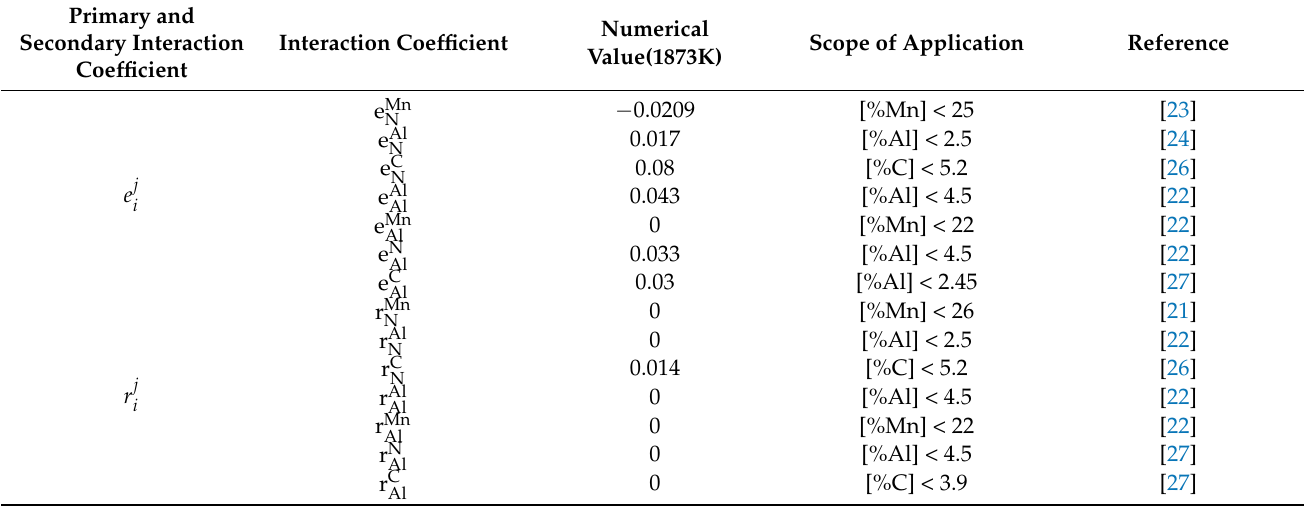
Table 3. Primary and secondary interaction coefficients most suitable for the thermodynamic calculation of TWIP steel.